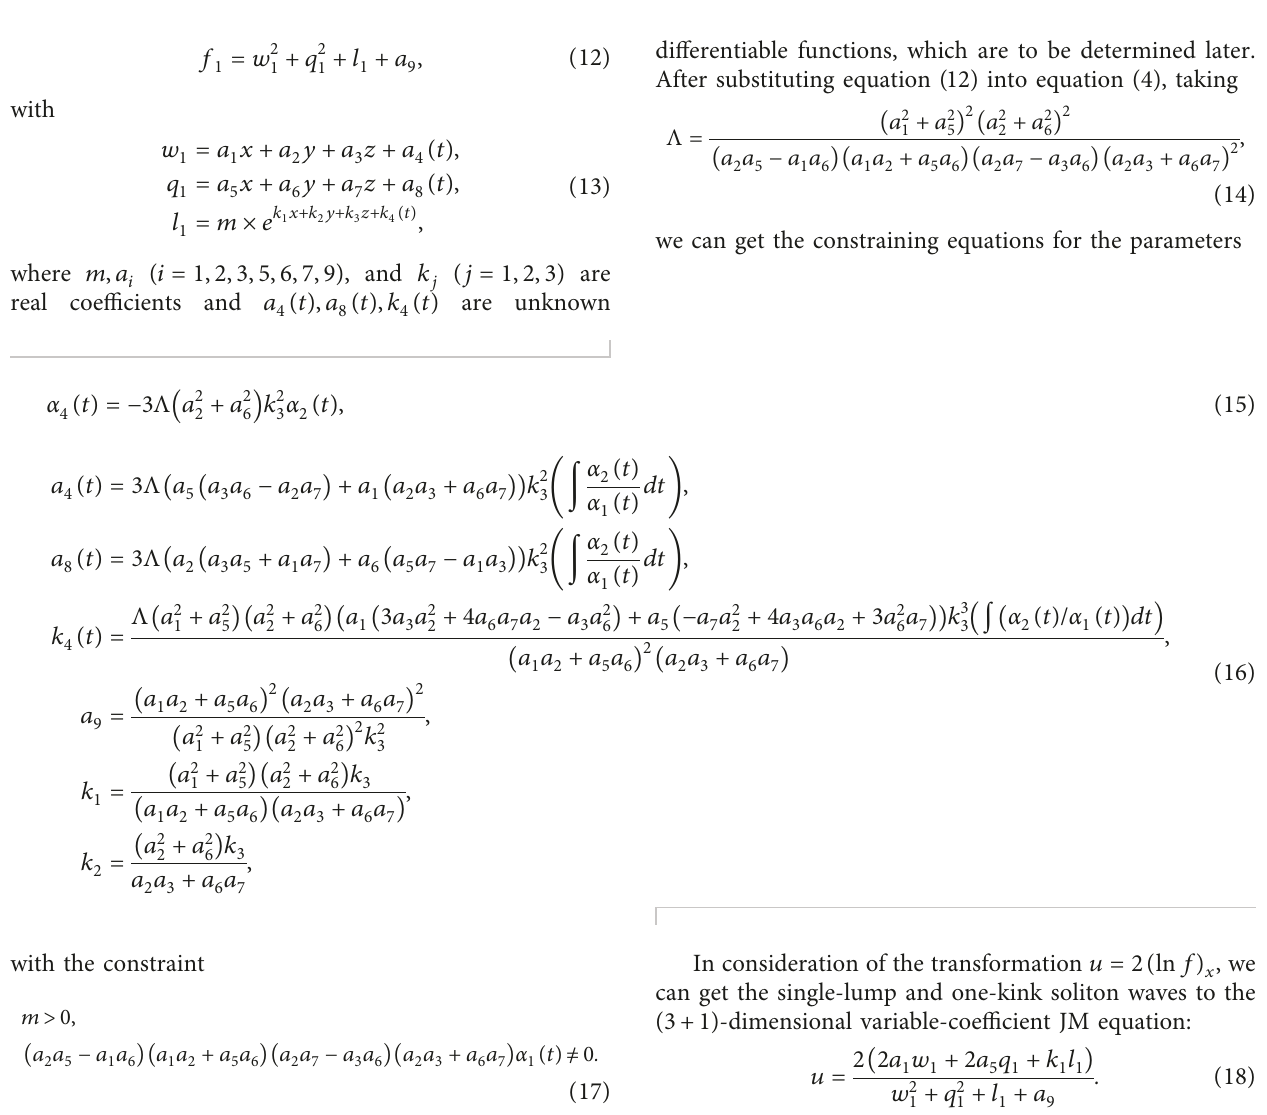
( t ) � 2 and α ( t ) � − ( 2/5 ) t . The other parameters are the same as 1 2